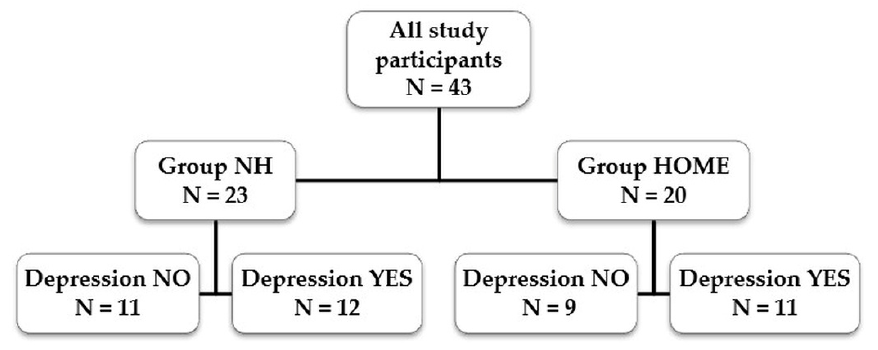
Figure 1. Study group—Geriatric Depression Scale (GDS) scores ≤ 9 points—Depression NO, score ≥ 10 points—Depression YES.